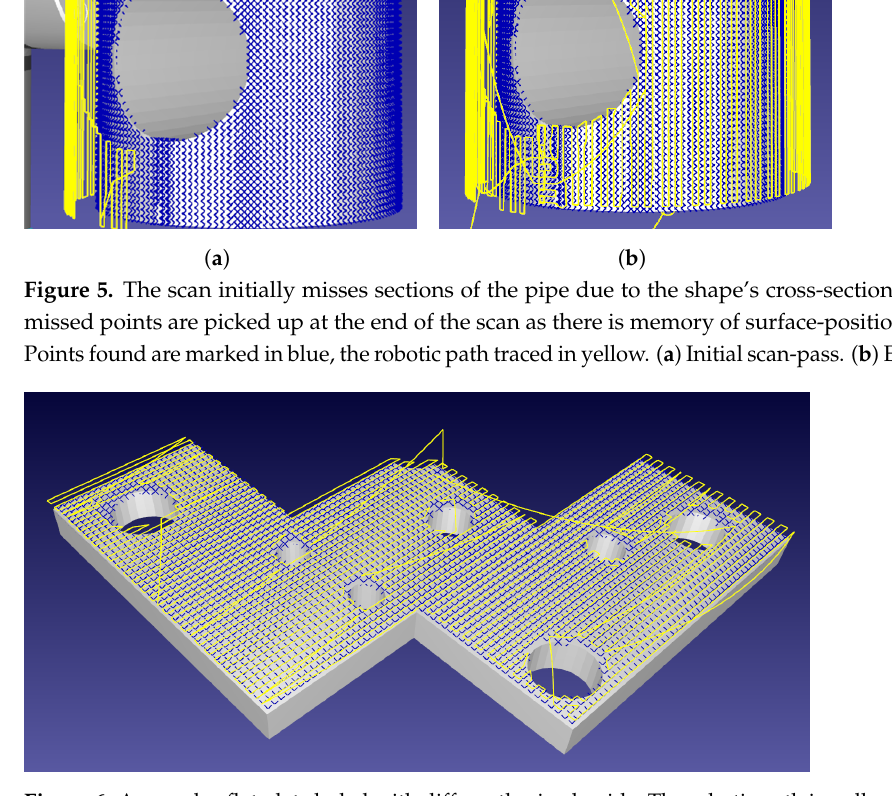
Figure 6. A complex flat plate holed with differently sized voids. The robotic path in yellow backtracks to allow for full surface discovery, shown by blue crosses, in the presence of surface-discontinuities.